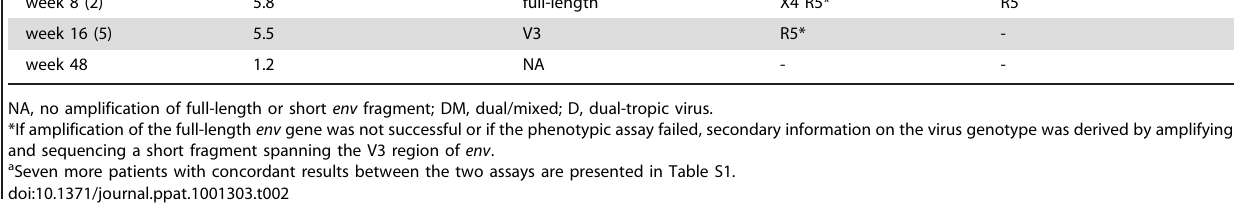
similarity between episomes and rebounding virus,